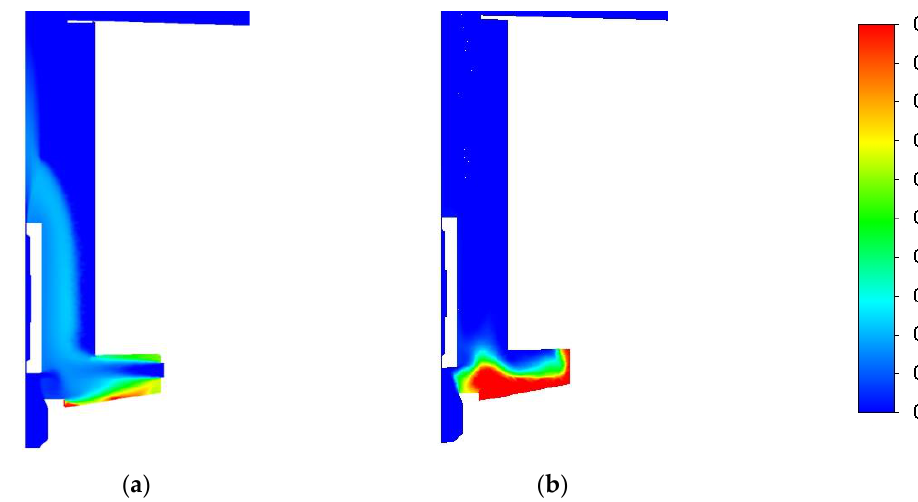
Figure 12. Temperature in the burner and at its outlet, °C: ( a ) EDC; ( b ) Flamelet-PDF.